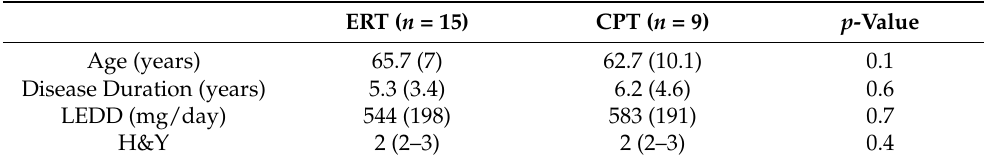
Table 1. Clinical-demographic features at baseline (T0). Data are reported as mean (SD) or median (interquartile range), and p -value of Mann–Whitney test.